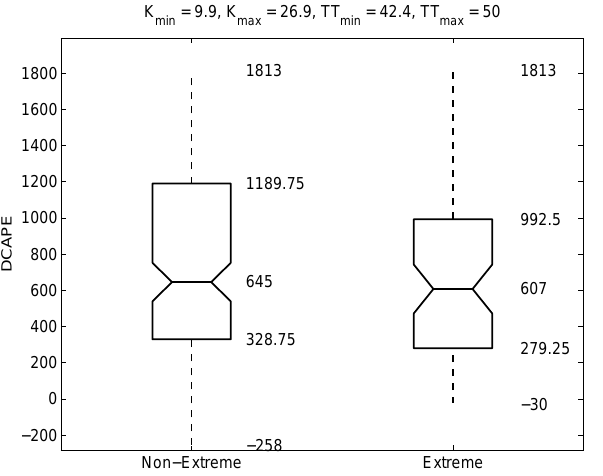
Fig. 5. The distribution of the values of the BRN index for the days where extreme (right) and non-extreme (left) events occurred. where extreme (right) and non-extreme (left) events occurred.